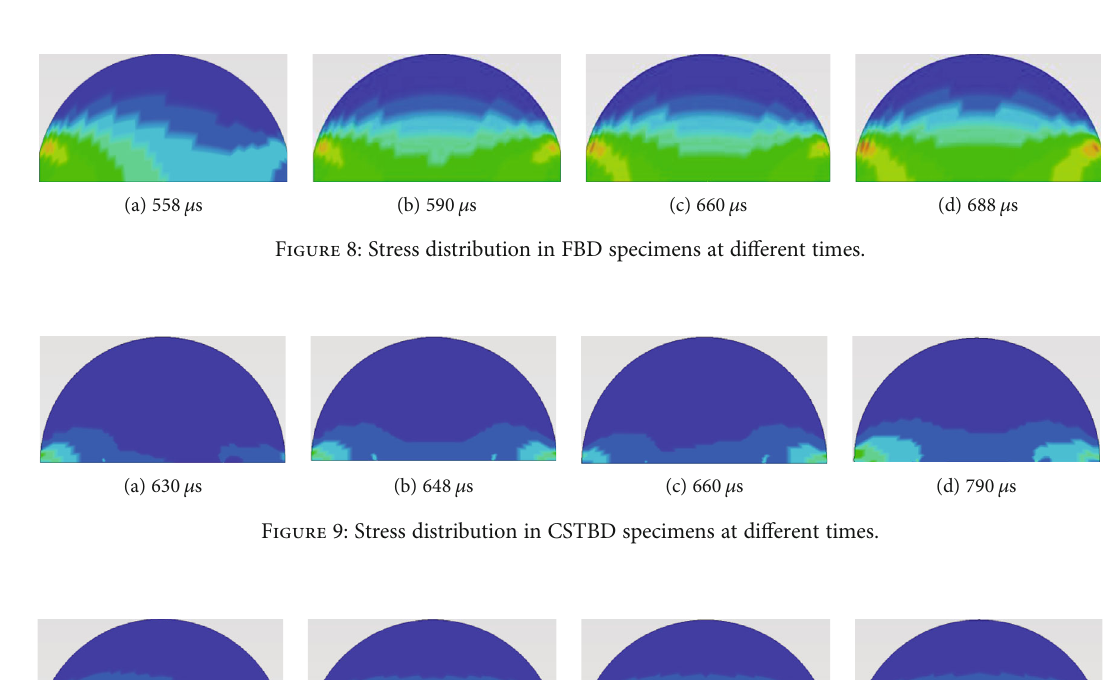
Figure 7: Stress distribution in BD specimens at di ff erent times.